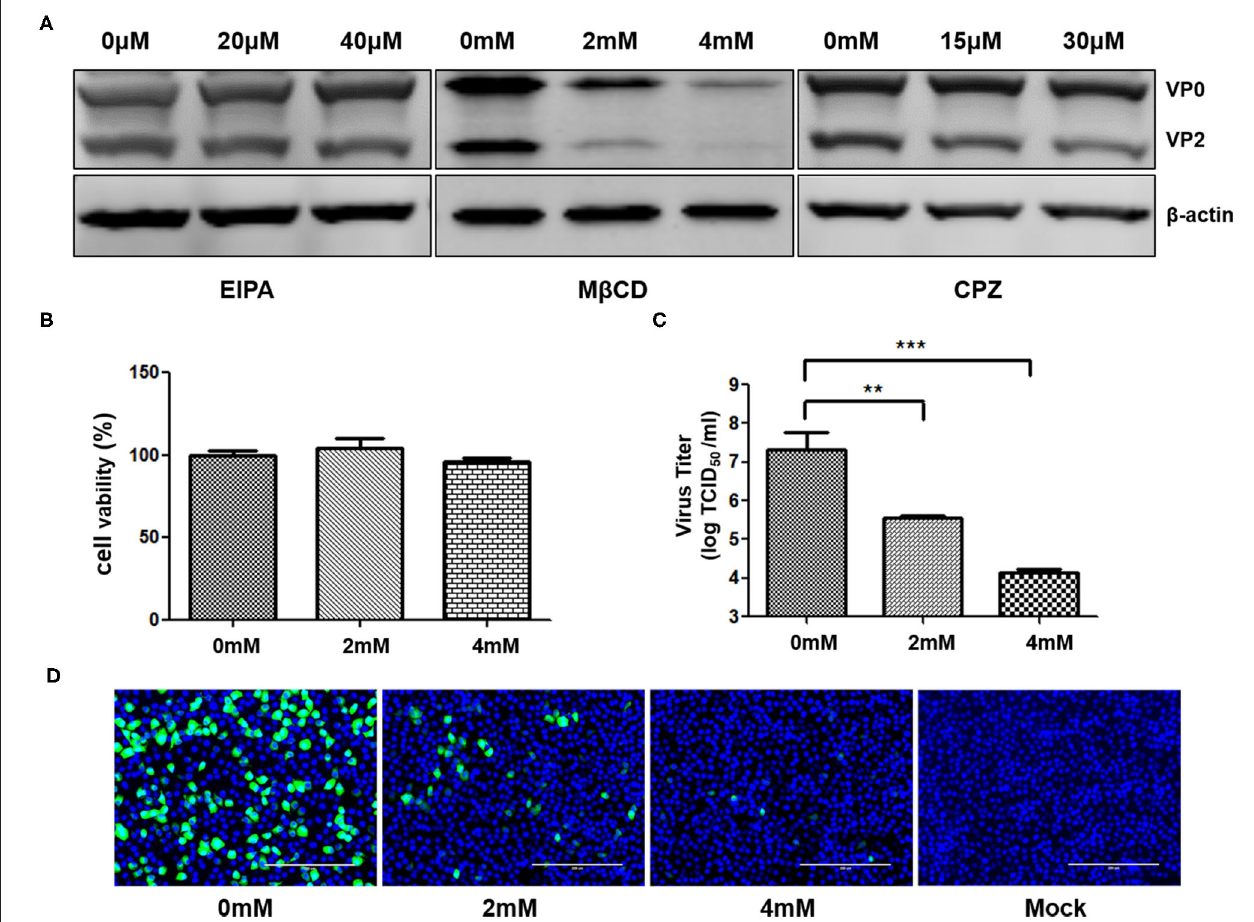
FIGURE 5 | SVA internalization depends on membrane cholesterol. PAM-Tang cells were pretreated with inhibitors prior to SVA infection. (A) The Western blot analysis for the expression of SVA VP2 and VP0 proteins from PAM-Tang cells that were pretreated with inhibitors. (B) The cell viability test assay. (C) The TCID 50 assay for viral titers (** P < 0.01, *** P < 0.001). (D) Immunofluorescent assay for EGFP (in green) expression level in the cells pretreated with M β CD. Bars, 200 µ